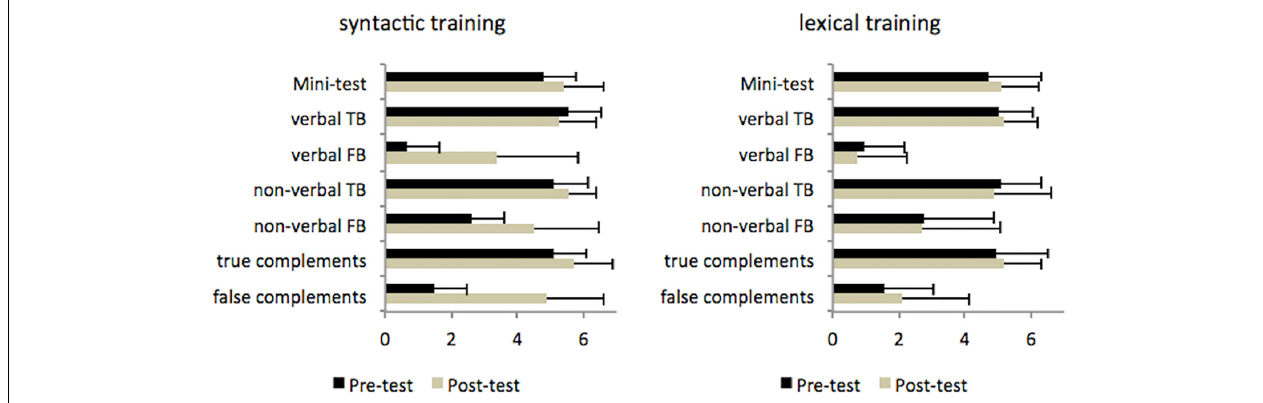
FIGURE 5 | Scores on ToM and complements tasks at pre-test and post-test for the syntactic and lexical